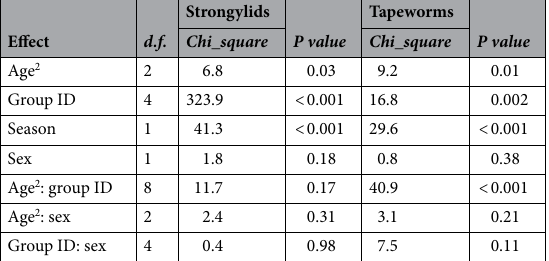
Table 4. Factors influencing helminth infections in the individual samples from five selected groups from Volcanos National Park collected in wet and dry season.